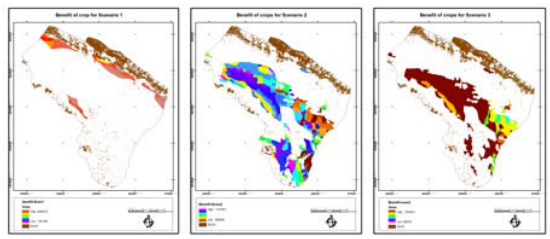
Figure 6: Benefit of Crop for